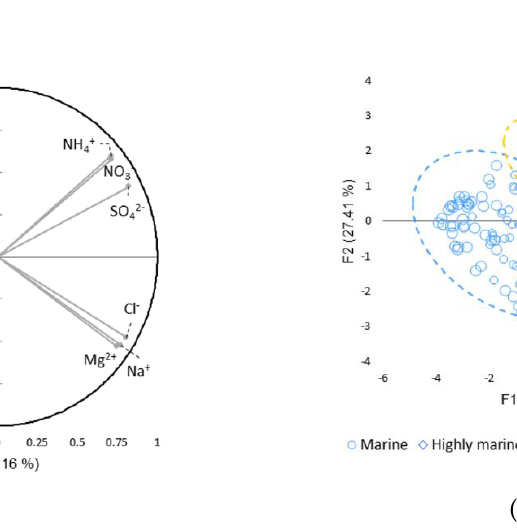
Figure 4. Principal component analysis (PCA) on a Spearman correlation chemical matrix. ( a ) Correlation circle and projection of the 6 ion concentrations; ( b ) Two-dimensional map of the colored observations according to the AHC category. The XLstat software automatically displayed confidence ellipses (interval 95%) around AHC categories, and resized points with squared cosines of the observations (i.e., the larger the point, the more it is related to a factor, F1 or F2) .